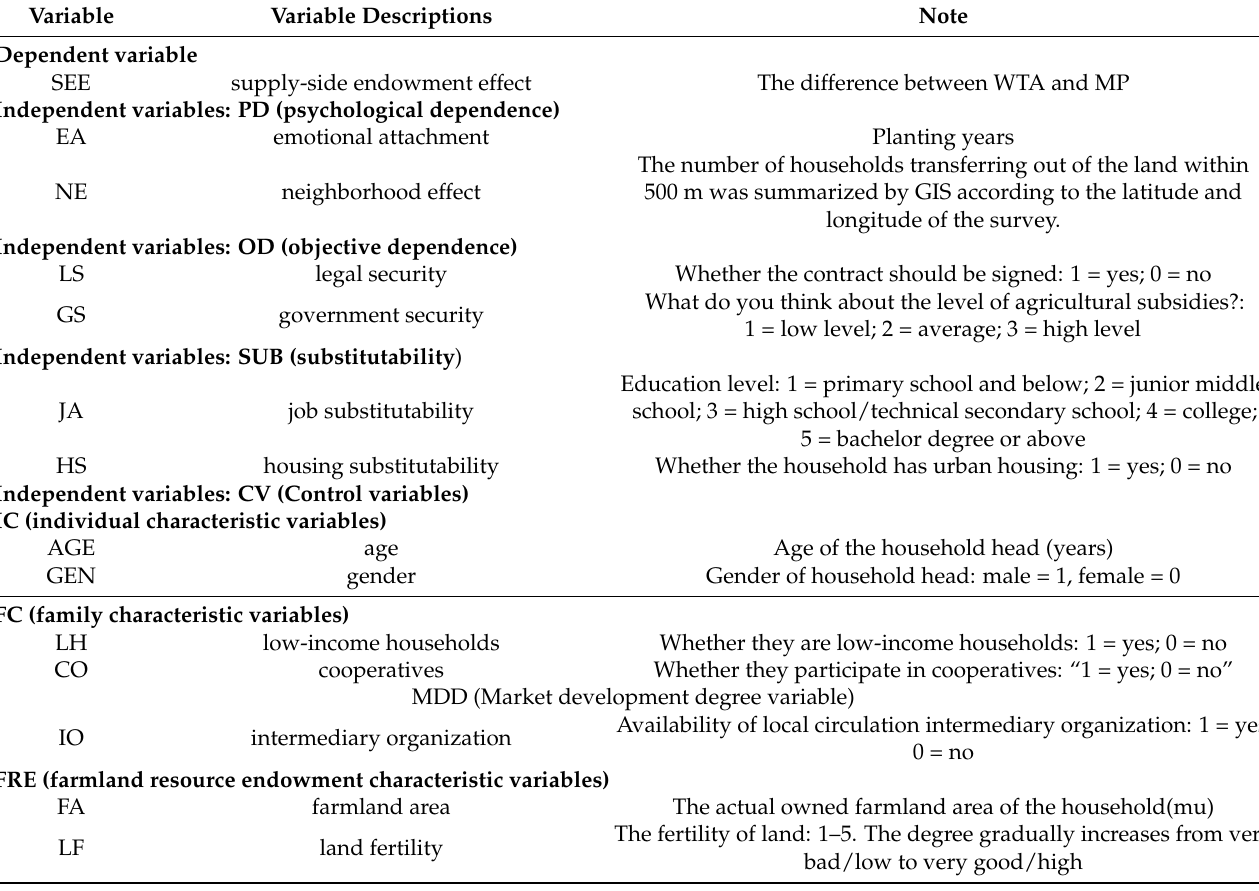
Table 1. Variable setting of supply-side endowment